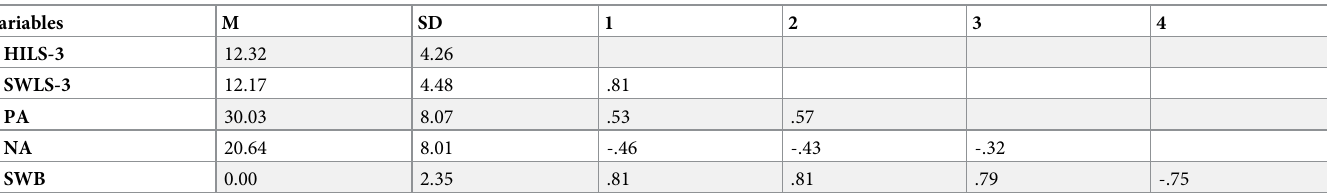
Table 1. Mean, SD, and Pearson correlations between SWB scales